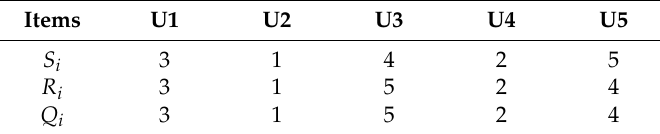
Table 23. The performance orders of all the alternatives.